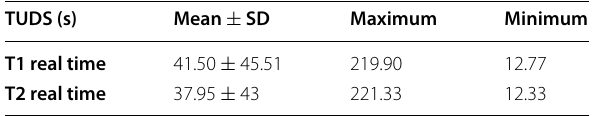
Table 2 Descriptive statistics of TUDS test measurements of